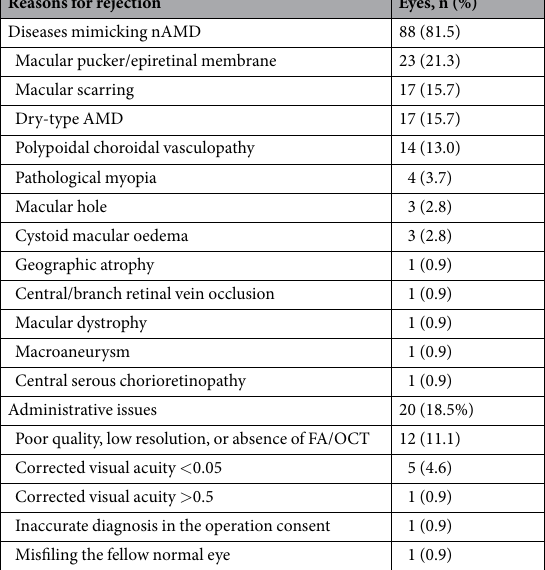
Table 2. Reasons for rejection in 108 eyes (95 patients) on first-time application for funding of ranibizumab by the national health insurance system. AMD, age-related macular degeneration; FA, fluorescein angiography: nAMD, neovascular age-related macular degeneration; OCT, optical coherence